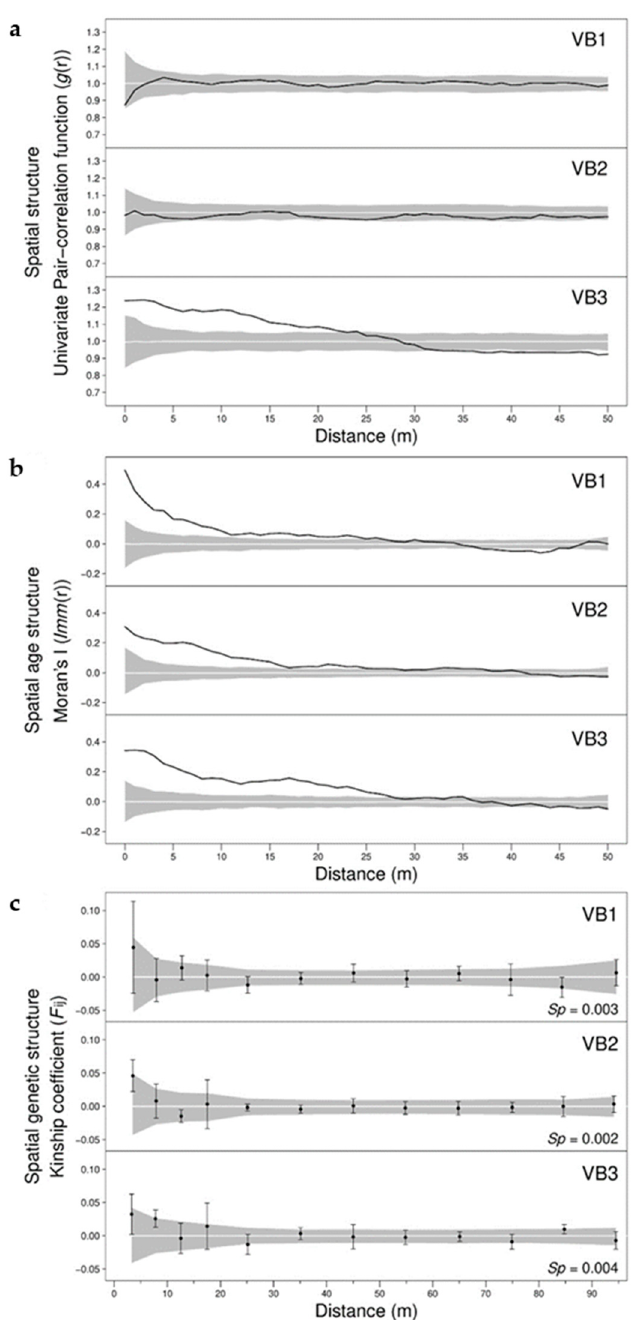
Figure 2. ( a ) Univariate pair-correlation function ( g (r)) on stem-mapped trees; ( b ) mark correlation analysis on trees’ age based on the normalized Moran’s I-mark statistic ( Imm (r)); ( c ) spatial autocorrelograms of the kinship coefficients F ij by Loiselle et al. [51] using even distance classes. The dark grey area represents the 95% CI around the null hypothesis (i.e., absence of spatial genetic structure), while black lines around mean F ij values are the 95% CIs estimated by jackknifing loci.